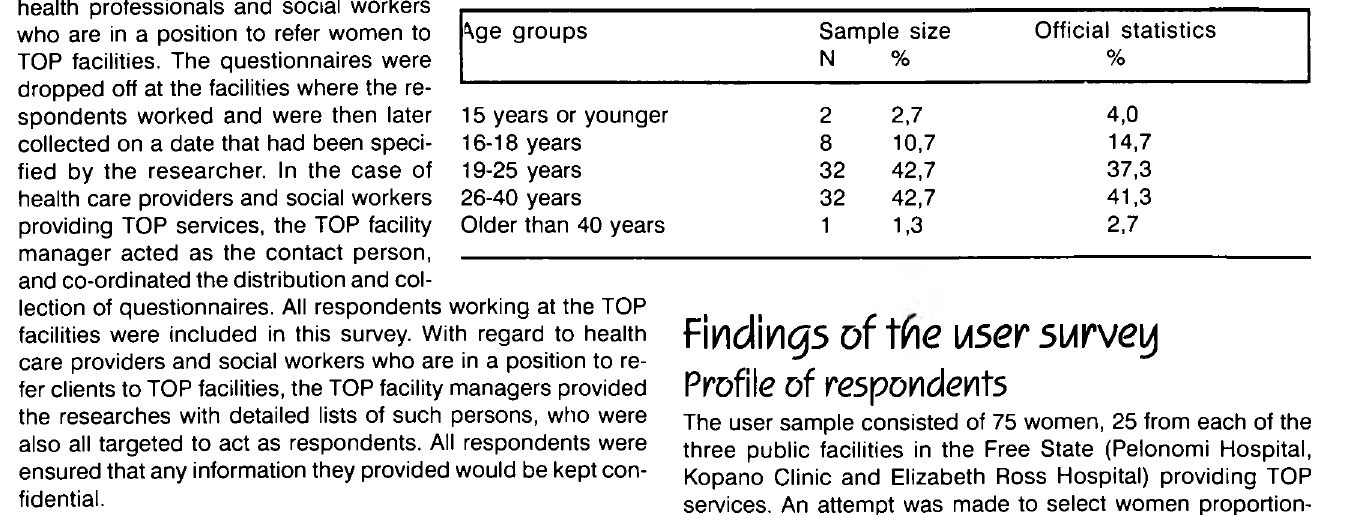
Table 1 : Age breakdow n of sam pled w om